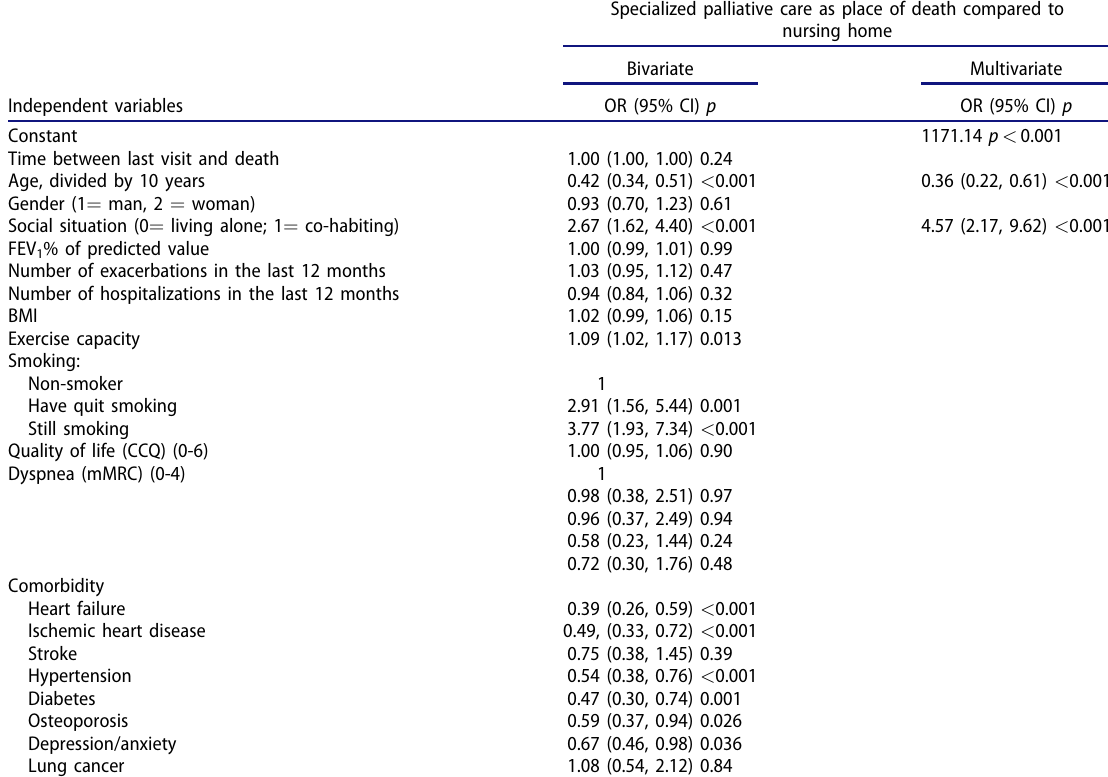
Table 4. Logistic regression with nursing home or specialized palliative care as place of death as dependent variable. Nursing home as reference variable, i.e. 0 and specialized palliative care as 1.